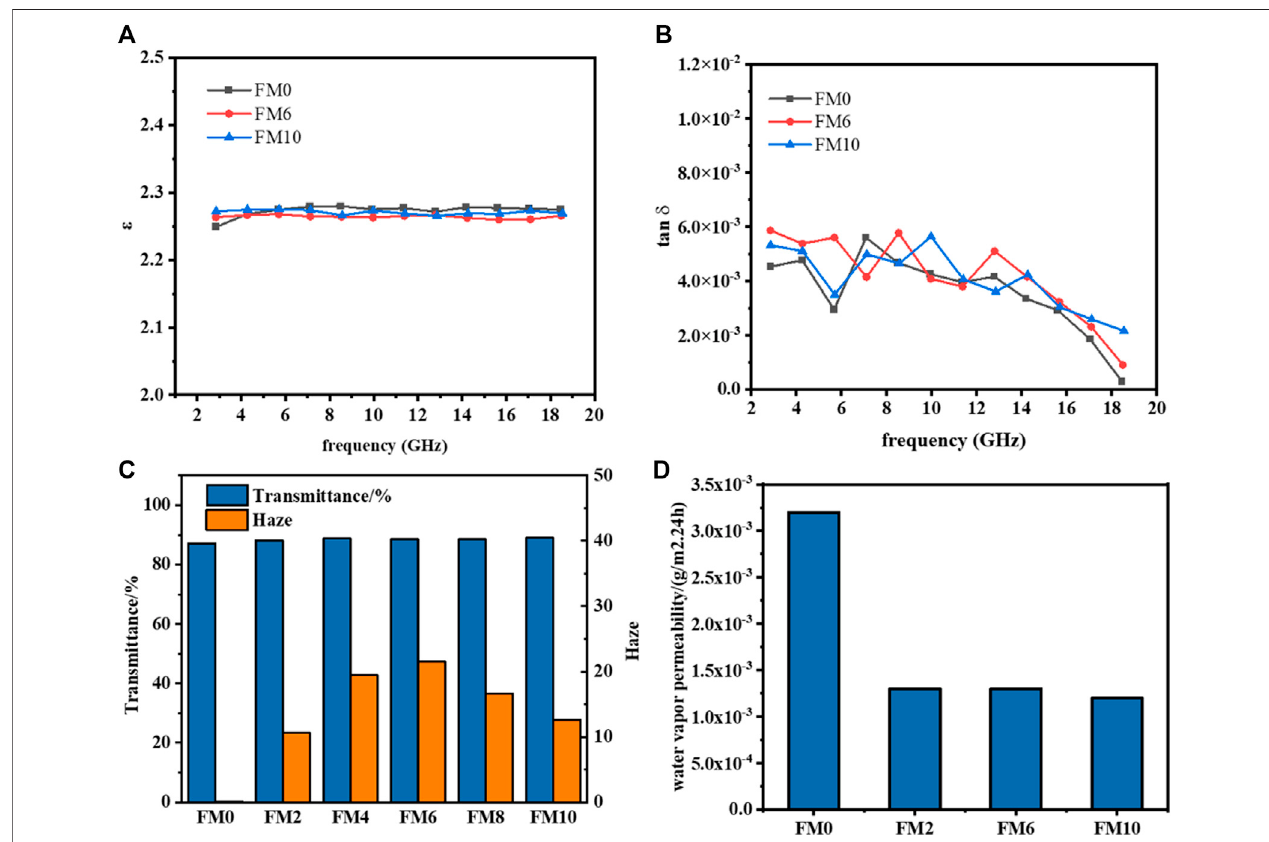
FIGURE 10 | Other macroscopic properties of PCTFE and PCTFE/FCO blends: (A) Dielectric constant; (B) dielectric loss; (C) transmittance and haze; (D) water vapor permeability.